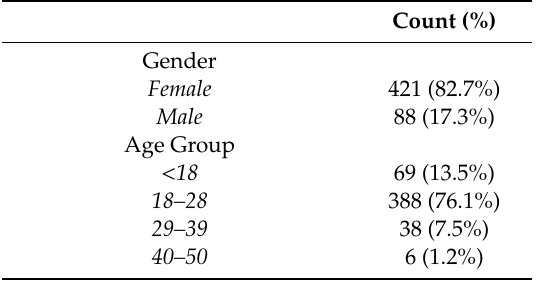
Table 1. Students’ demographic and academic characteristics ( n =